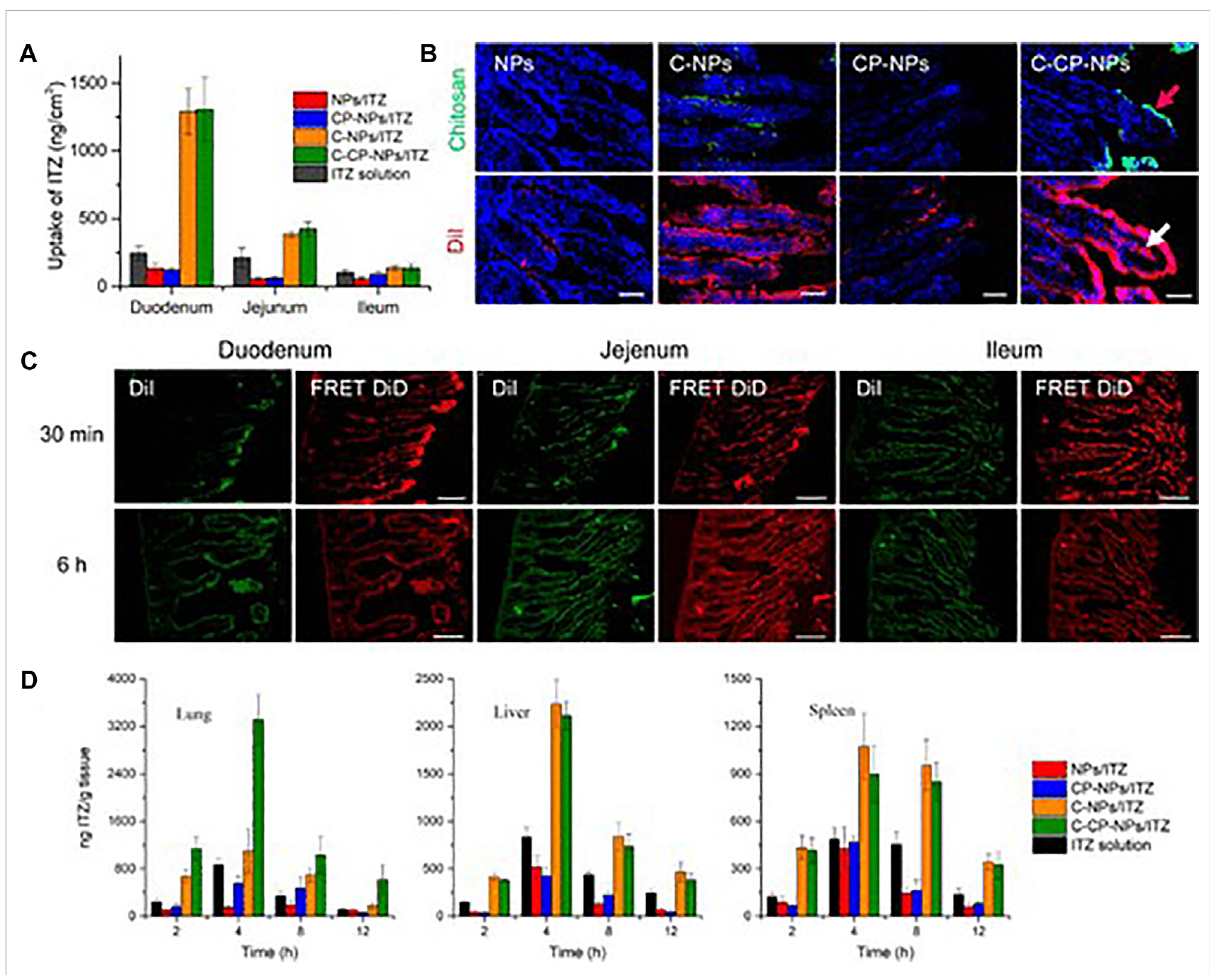
FIGURE 4 Enhanced intestinal absorption of encapsulated drugs and in vivo targeting ef fi cacy of C-CP-NPs. (A) In vivo intestinal absorption of ITZ of different formulations. (B) Fluorescence images showing localization of chitosan and NPs in duodenum, where chitosan was labeled with FITC (green) and NPs were labeled with DiI (red). (C) Fluorescence images of DiI channel (green) and FRET DiD channel (red) at 30 min and 6 h post-oral administration. Scale bars, 100 µm. (D) Tissue distribution of ITZ in major organs of C. Neoformans-infected mice after oral administration of 40 mg kg − 1 NPs loaded with ITZ or marketed drug solutions. Data are shown as mean ± SD ( n ≥ 3) (Tang et al., 2018). It was